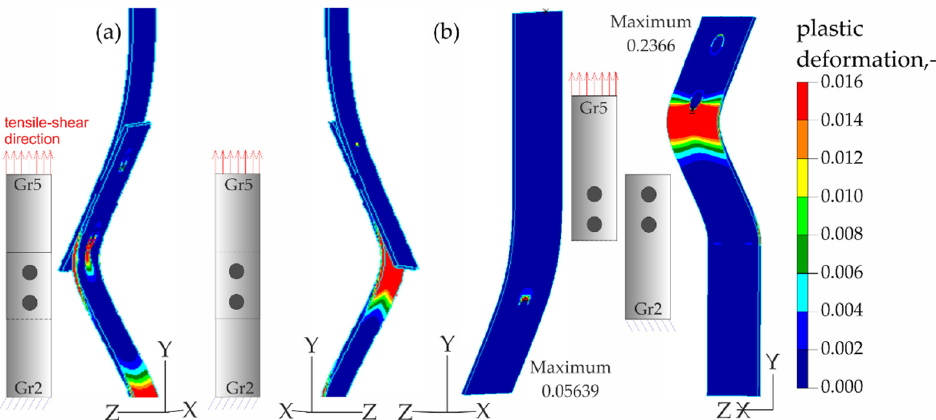
Figure 16. Distribution of plastic deformations in the Gr2–Gr5-1 joints: ( a ) on the surface of the entire joint and ( b ) on the inner surfaces of the joints.